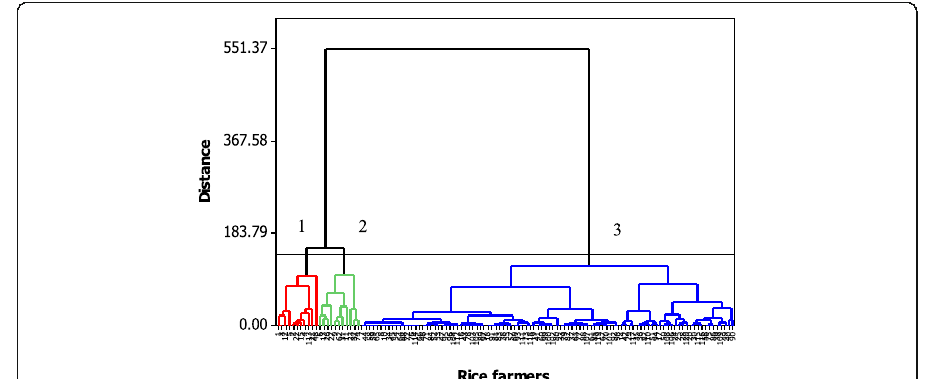
Fig. 2 Dendrogram showing the clusters identified from the hierarchical ascending classification. 1, 2, and 3 represent the numbering of the